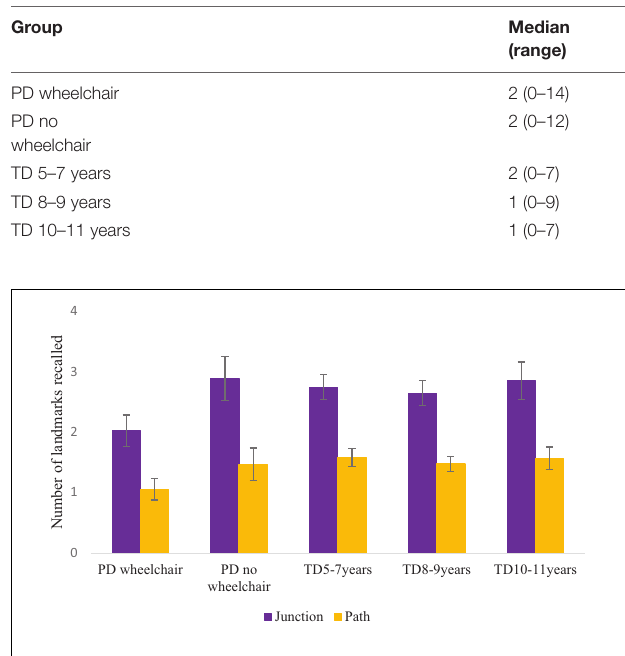
FIGURE 7 | Mean (S.E.) number of landmarks recalled per group.